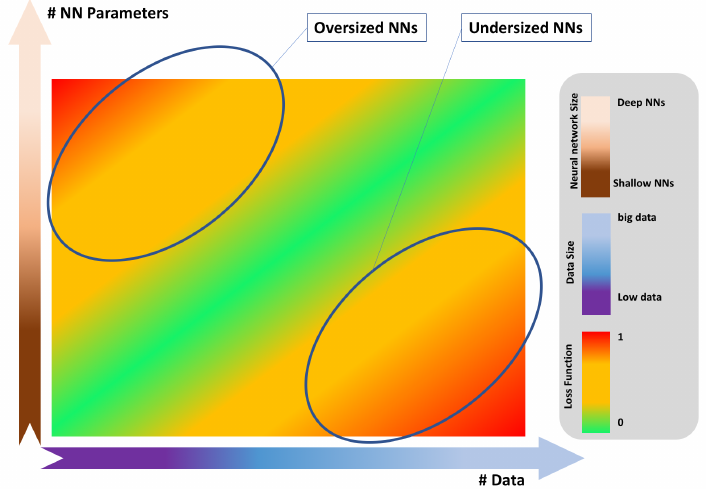
Figure 6. The correlation between the size of the training data and NN